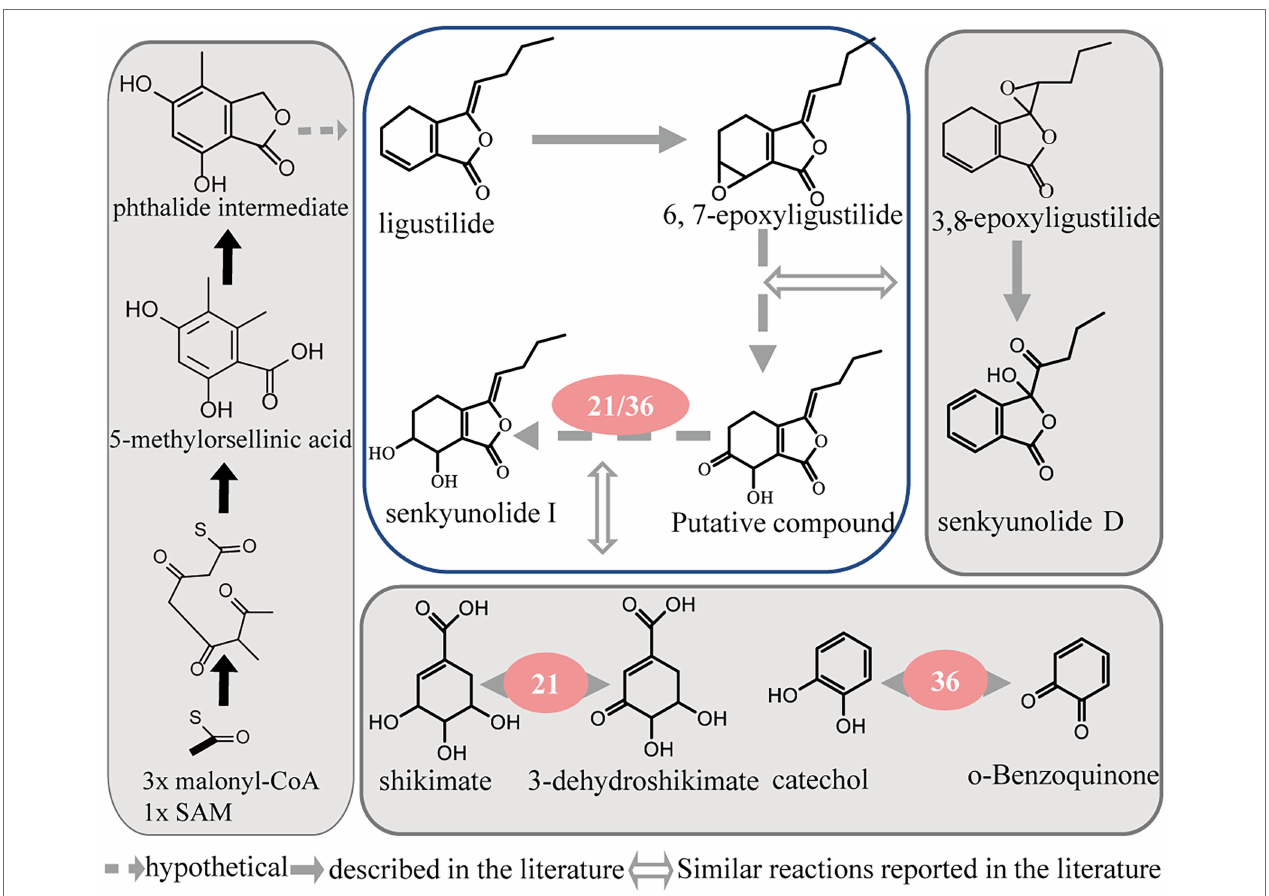
FIGURE 6 | Proposed reaction pathways from ligustilide to senkyunolide